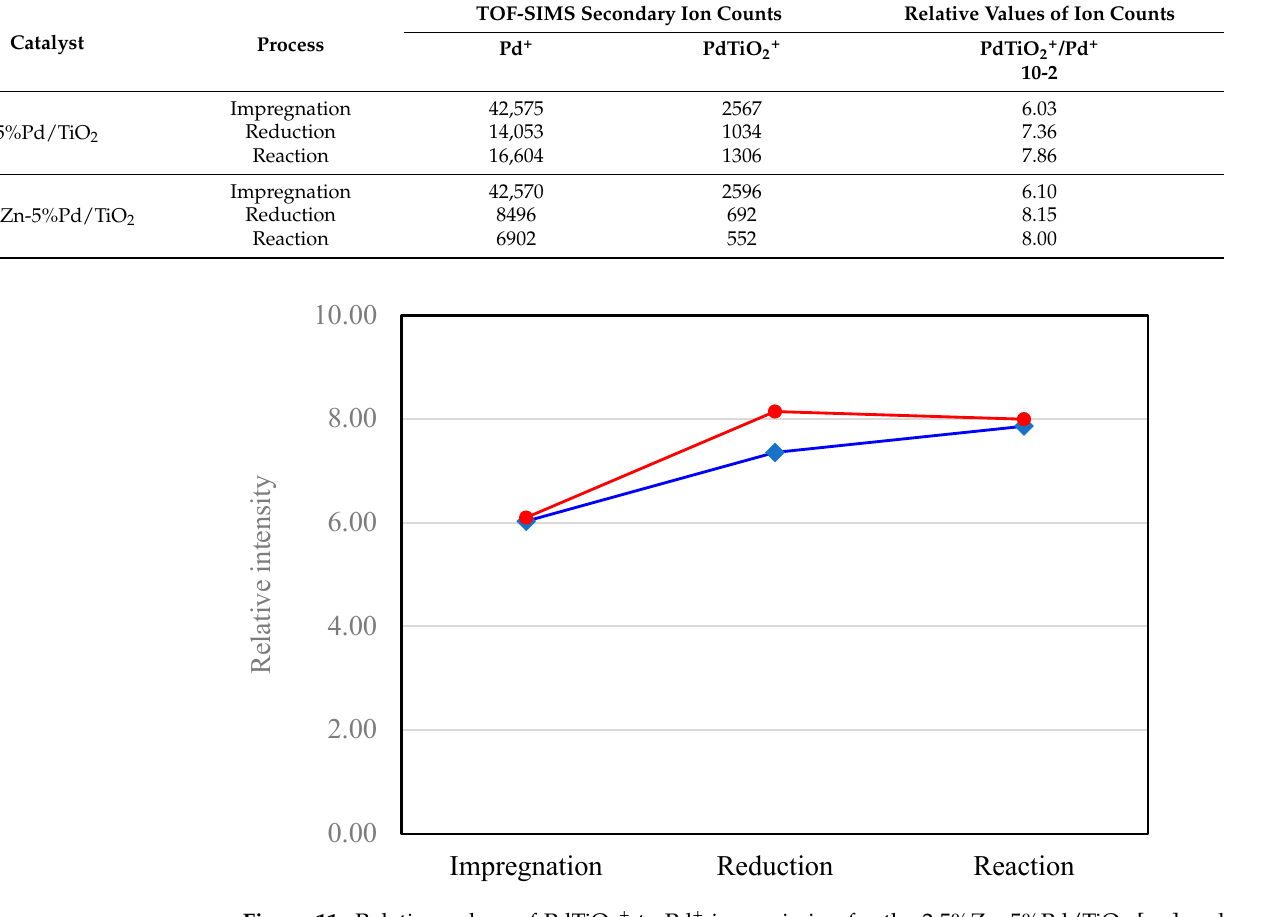
Figure 11. Relative values of PdTiO 2 + to Pd + ion emission for the 2.5%Zn–5%Pd/TiO 2 [- • -] and 5%Pd/TiO 2 catalysts [- (cid:7)